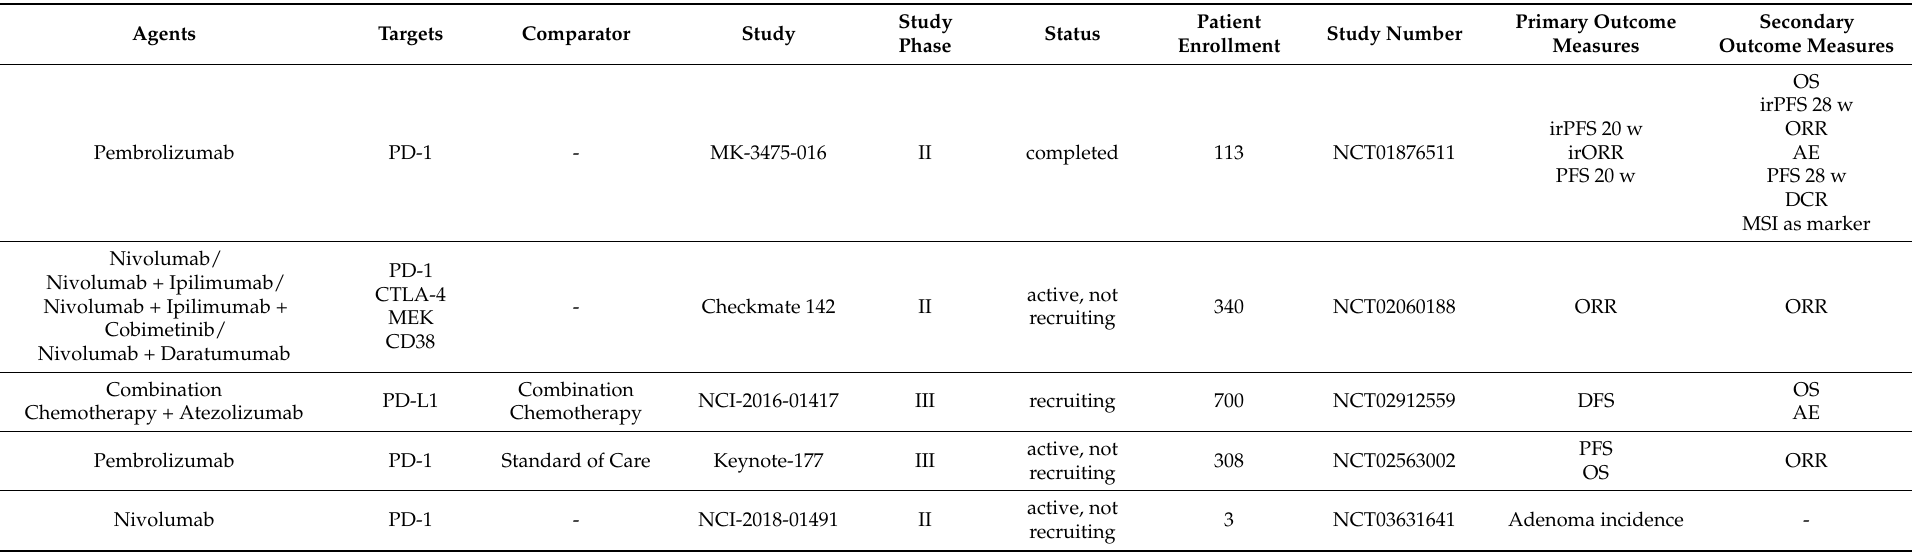
Table 6. Trials with immunotherapy in Lynch